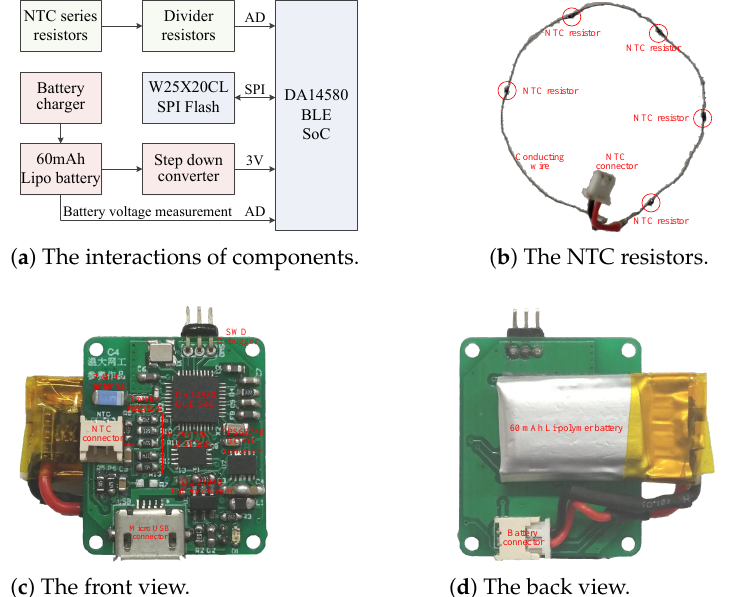
Figure 4. The block diagram and realization of sensor